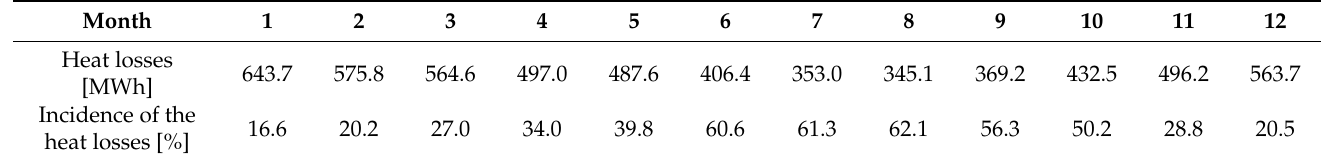
Table 2. Thermal losses in the DH network (year 2019).